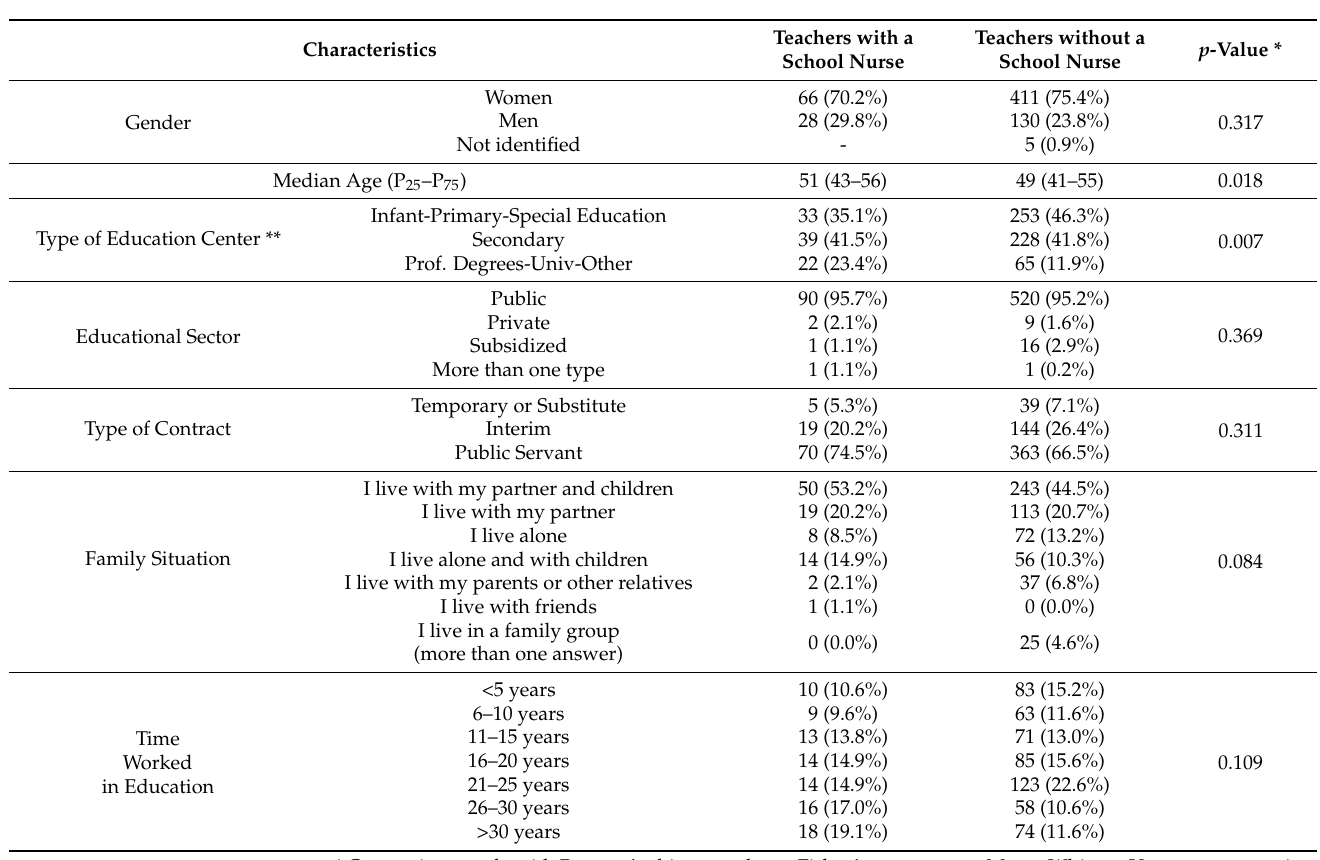
Table A2. Demographic and employment information of the participants in general and according to whether or not they have a healthcare professional in their center.